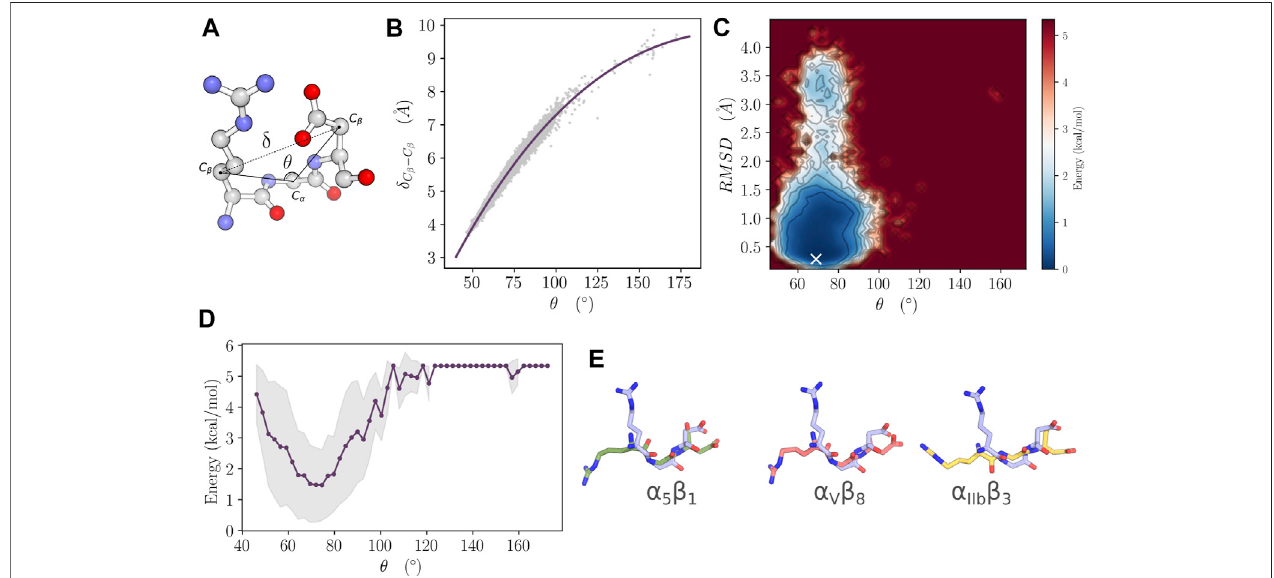
FIGURE 4 | Free energy landscape analysis of the RBD. (A) δ C β − C β distance and the θ angle are indicated on the structure of the RGD segment from RBD. (B) Correlation of δ C β − C β and θ . Datawere fi tted toapolynomial model ( R 2 = 0.97). (C) Free energy landscape asafunctionof θ and the RMSD ofthe C1residue cluster. The white marker indicates the position of the global minimum. (D) Variation of the energy as a function of θ . The gray shading indicates the boundaries de fi ned by the standarddeviation oftheenergy averaged alongthereaction coordinate. (E) TheRGDstructure correspondingtotheminimumofenergy(light blue)was fi ttedand compared to the RGD structure in its bound form with α 5 β 1 (Green), α V β 8 (light pink) and α IIb β 3 (Yellow)